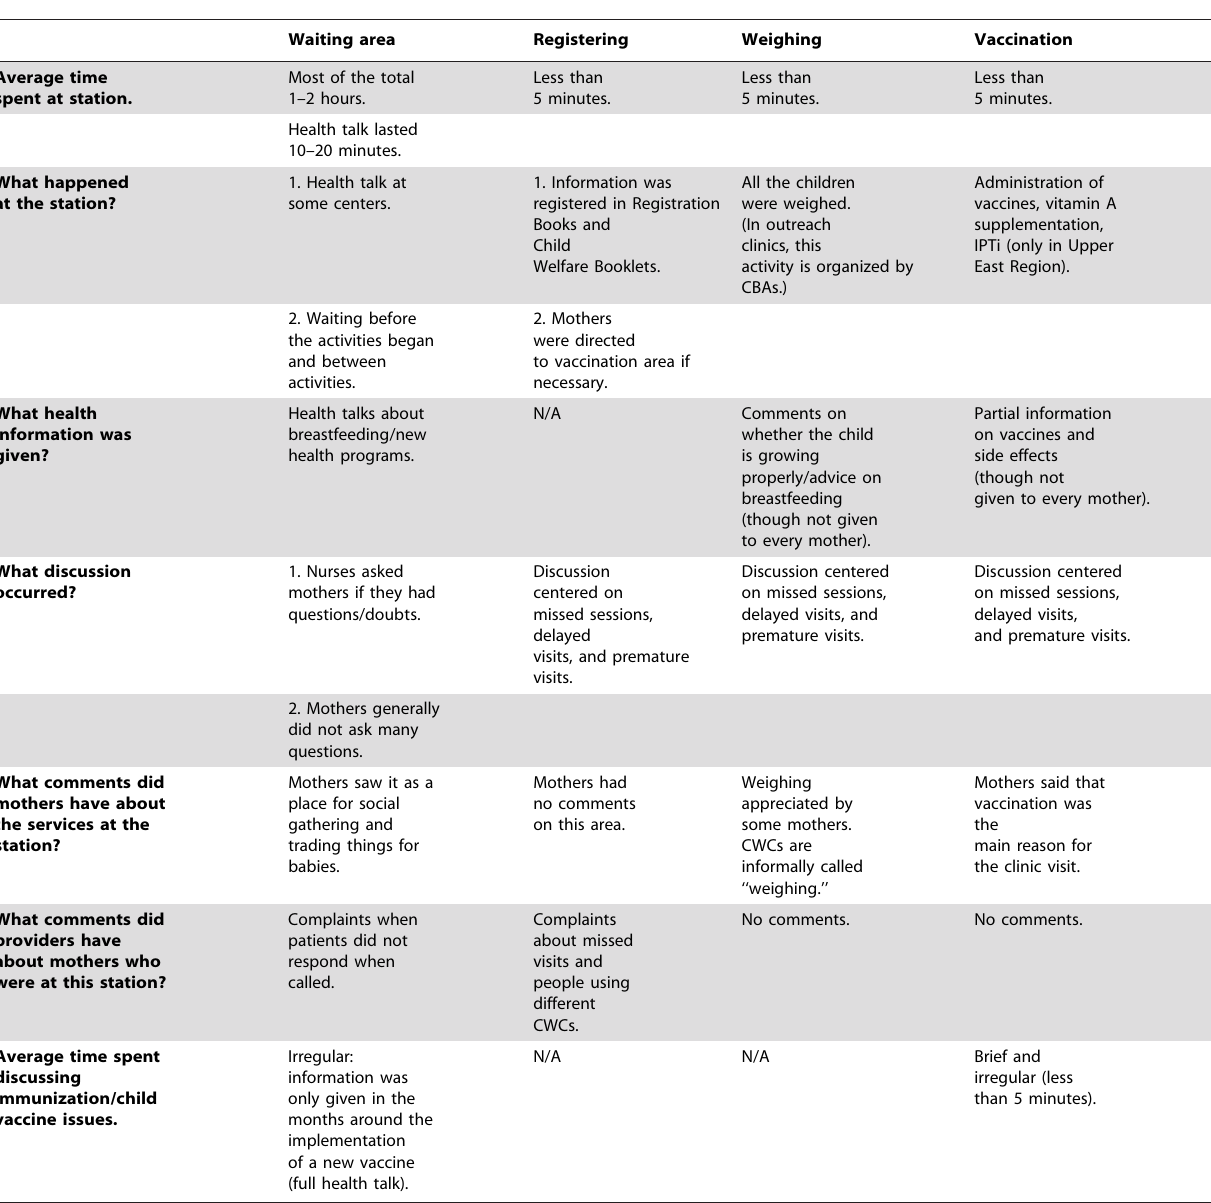
Table 4. Child Welfare Clinic structure.